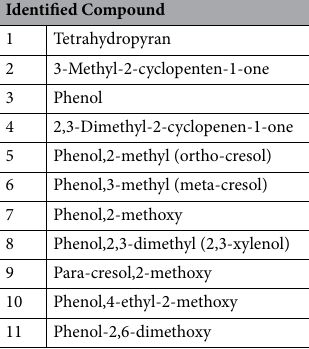
Table 1. Main chemical compounds identified in the distilled pyroligneous extract. *Based on mass spectroscopy analysis (Porto et al. 30